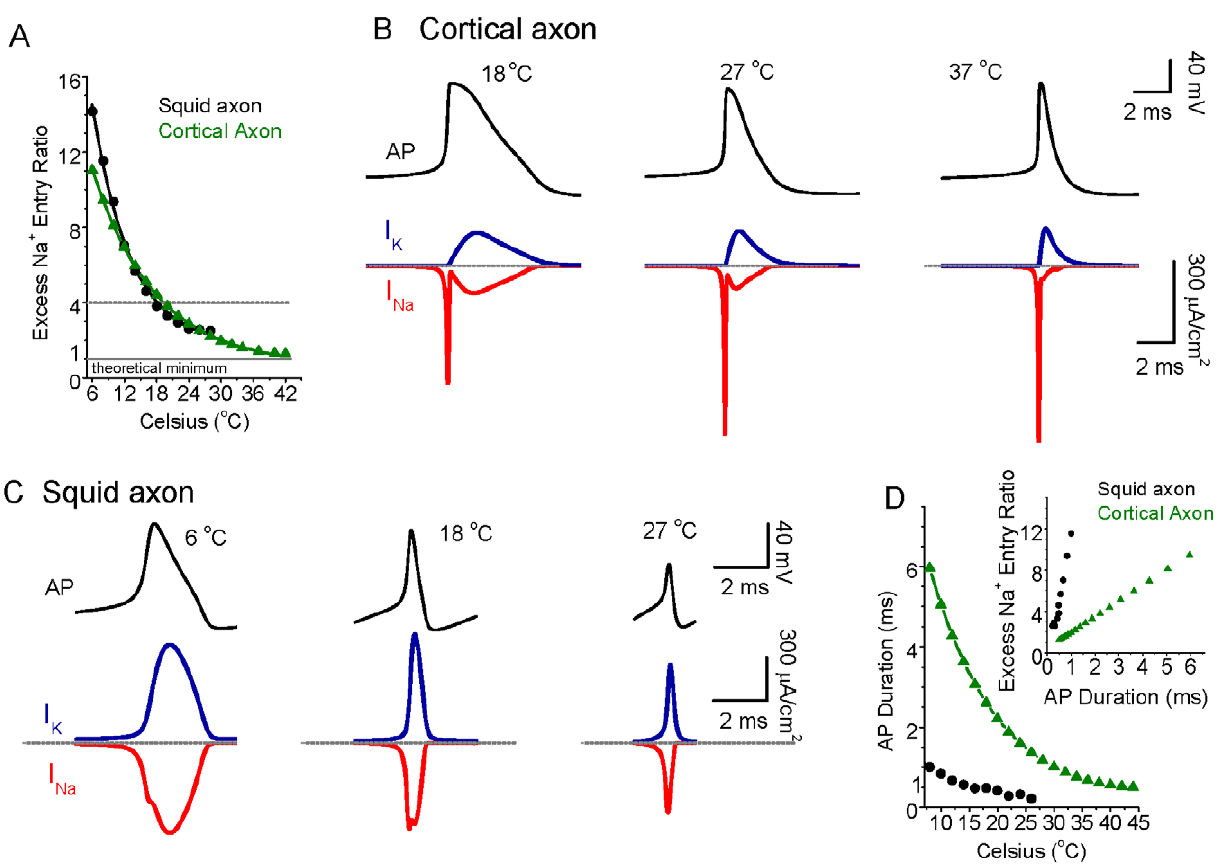
Figure 1. The energy efficiency of action potential generation increases as temperature increases. A. Na + entry ratio (defined as a ratio of the total actual sodium entry to the minimal amount needed to generate an action potential, i.e., # I Na (t)dt/(C m D V), where I Na (t) is the sodium current, C m is membrane capacitance, D V is the change in voltage during the action potential) as a function of temperature. For both the HH simulation of the squid giant axon (DC injection 20 6 10 2 2 pA/ m m 2 ), and for a model of cortical pyramidal cell axons (DC injection 0.5 6 10 2 2 pA/ m m 2 ), increasing temperature strongly decreases the excess Na + entry during action potential generation. At 18 u C, this entry ratio is approximately 4 (dashed line), while at 37 u C, this excess entry reaches 1.89 (HH, extrapolated) and 1.41 (cortical axon), which is close to the theoretical minimum. B. Top panel: the action potential of the cortical model neuron generated at 18, 27 and 37 u C, respectively; Bottom panel: the corresponding Na + and K + currents during action potential generation for temperature at 18, 27 and 37 u C, respectively. Note that there is substantial overlap of Na + and K + currents during action potential generation for 18 u C, reduced overlap at 27 u C and much less overlap at 37 u C. The largely non-overlapping nature of the ionic currents at high temperature results in considerably lower excess Na + entry ratio. Dashed lines indicate the peak of each action potential for reference. C. Top panel: the action potential of classical HH model neuron generated at 6, 18, and 27 u C, respectively; Bottom panel: the corresponding Na + and K + currents during action potential generation for temperature at 6, 18, and 27 u C, respectively. Notice that the overlap of Na + and K + currents during action potential generation is also reduced when temperature increases. D. The half-height spike duration decreases as a function of temperature increase for both classical HH neuronal model (black) and cortical neuronal model (green). Inset: The correlation between excess Na + entry ratio and spike duration for both models. The large spike duration corresponds to a large Na + entry ratio, indicating reduced energy